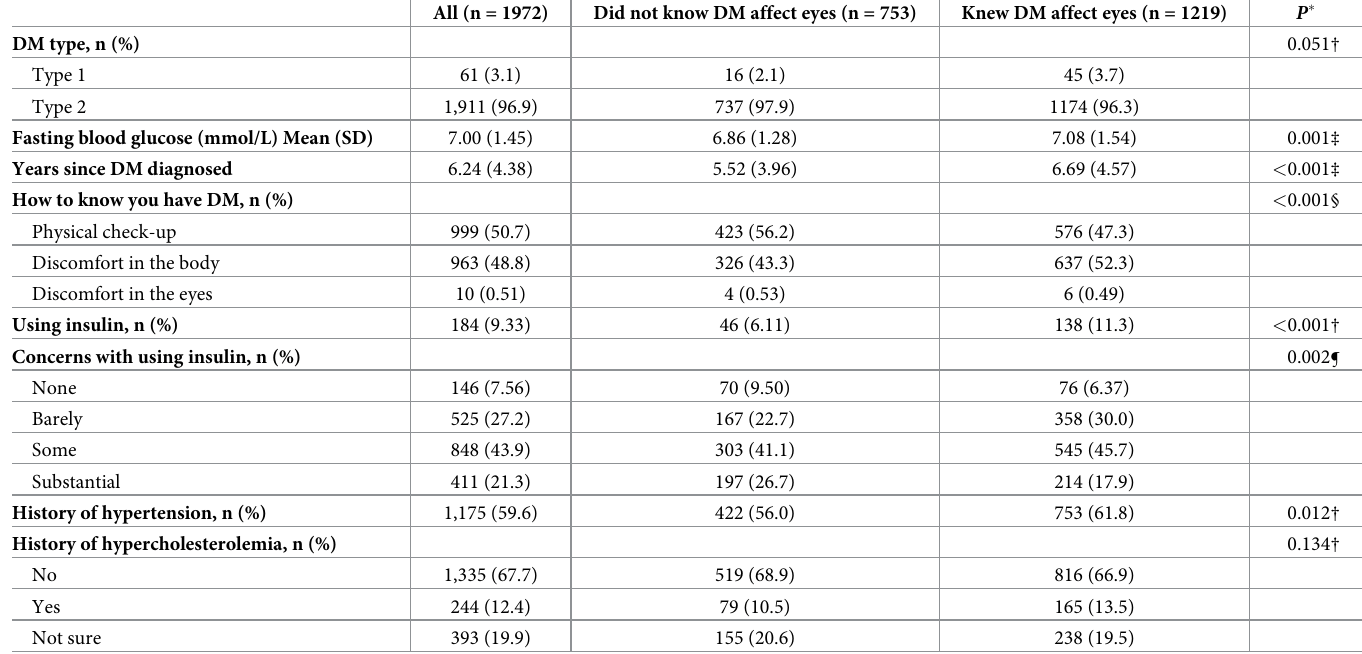
Table 2. Medical history of diabetes among study participants by their knowledge of